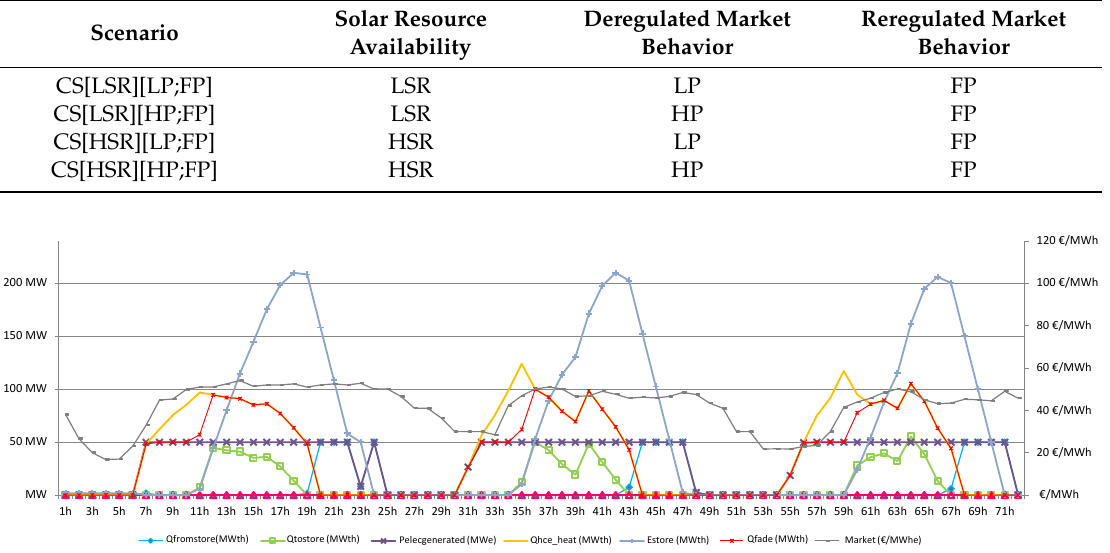
Figure 5. Hourly programming of optimal production CS[HSR][LP][26].